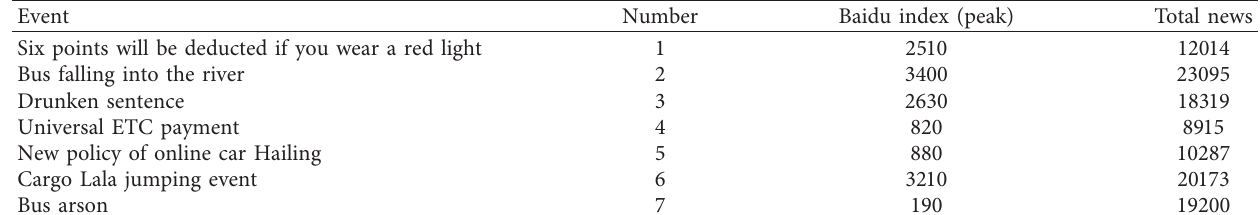
Figure 5: Indicator system. Table 1: Events and Baidu data.